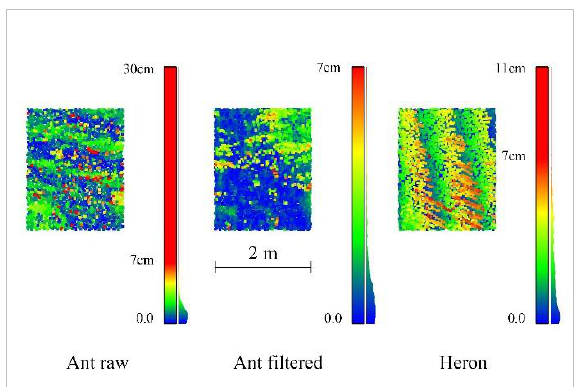
Figure 9. Data noise check performed on a portion of the vertical wall of the bell tower by calculating the C2M distance between the PCs and the correspondent fitting plane. Color bars have the same scale.